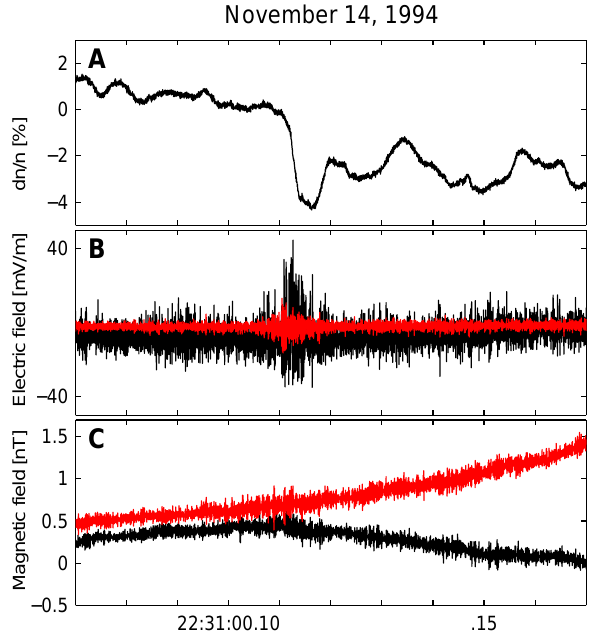
Fig. 1. Panel A shows the density variations observed along the satellite trajectory (perpendicular to B 0 ). The two recorded electric wave field components are shown in panel B. The black and red lines are the most perpendicular and the most parallel E -field component respectively. For both components we note a clear enhancementassociatedwiththedensitygradient. InpanelCcorrespondingmagneticwavefieldsarepresented. Here the spin axis component (black line) has an angle of 77 ◦ to B 0 and the spin plane component (red line) hasanangleof43 ◦ to B 0 . Theincreaseinthemagneticwaveactivityisbarelyvisible.